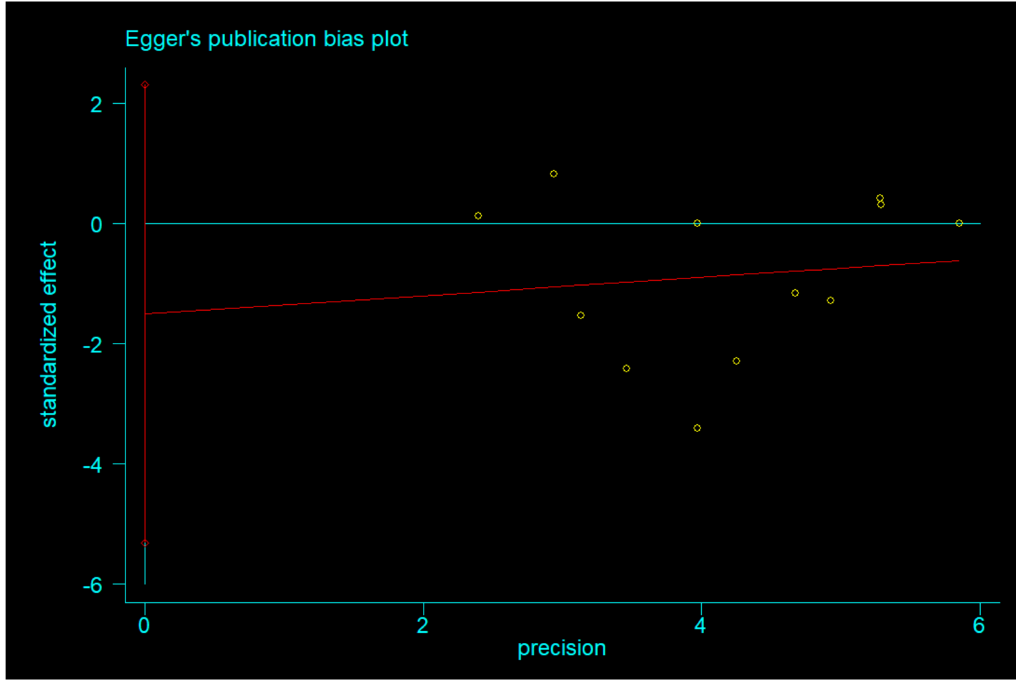
Figure 12. Egger’s publication bias plot of body